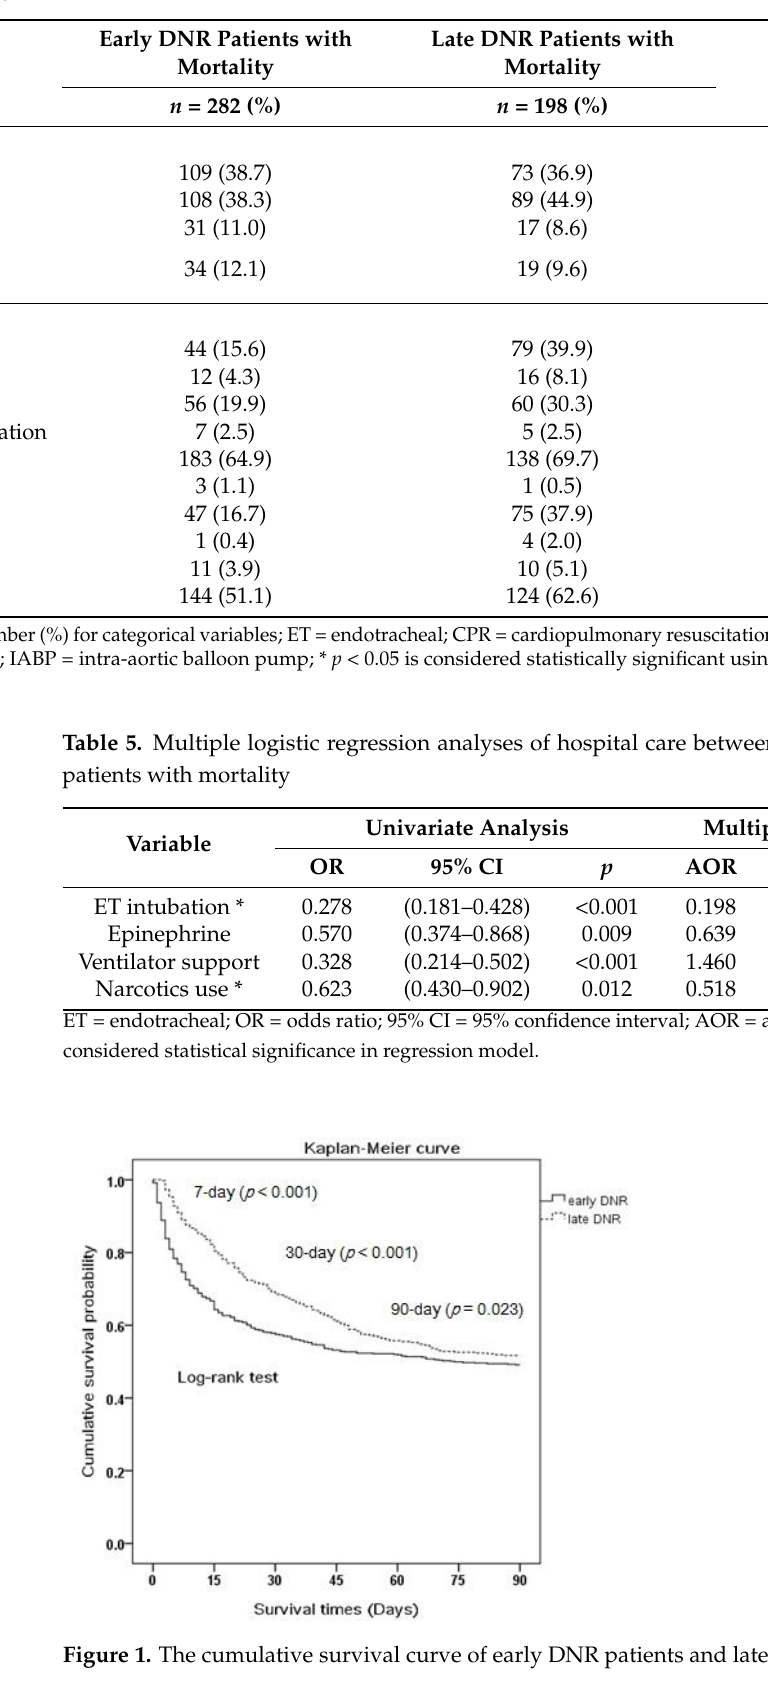
Table 4. Comparison of hospital care in hospitalization between 282 early DNR patients with mortality and 198 late DNR patients with mortality.